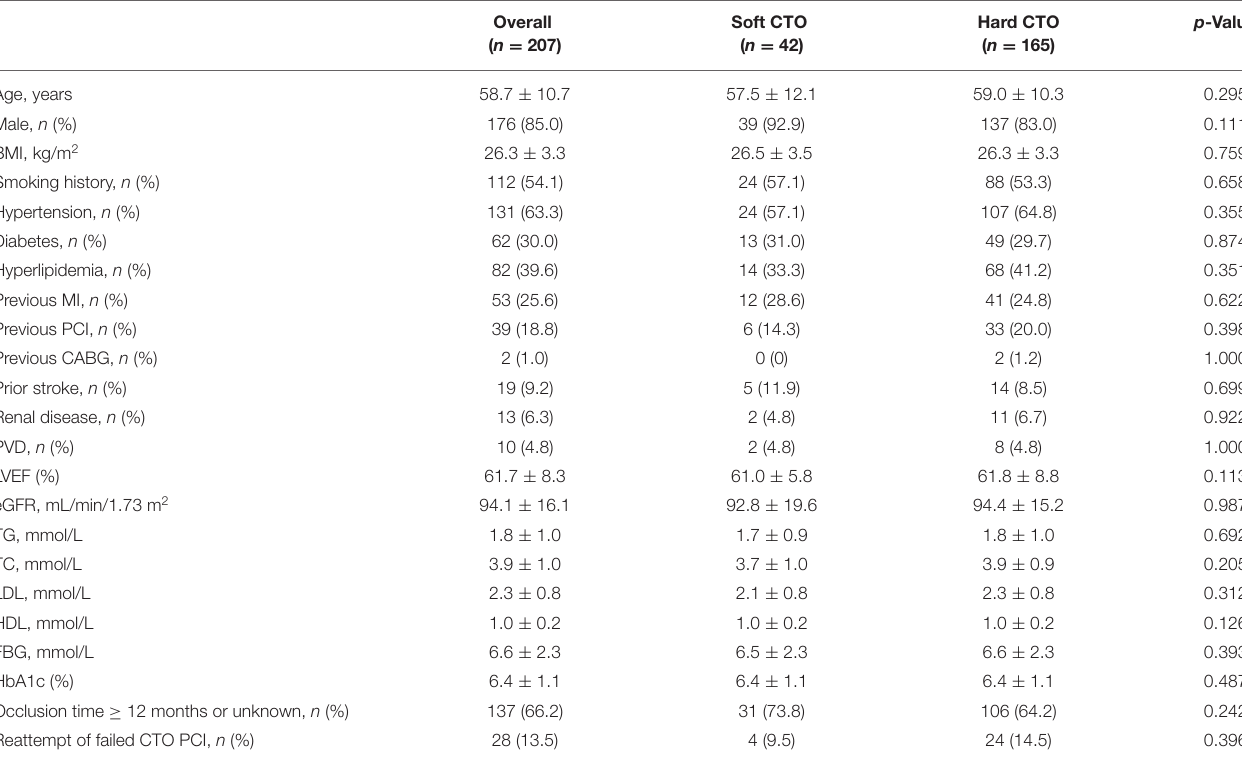
TABLE 1 | Baseline clinical